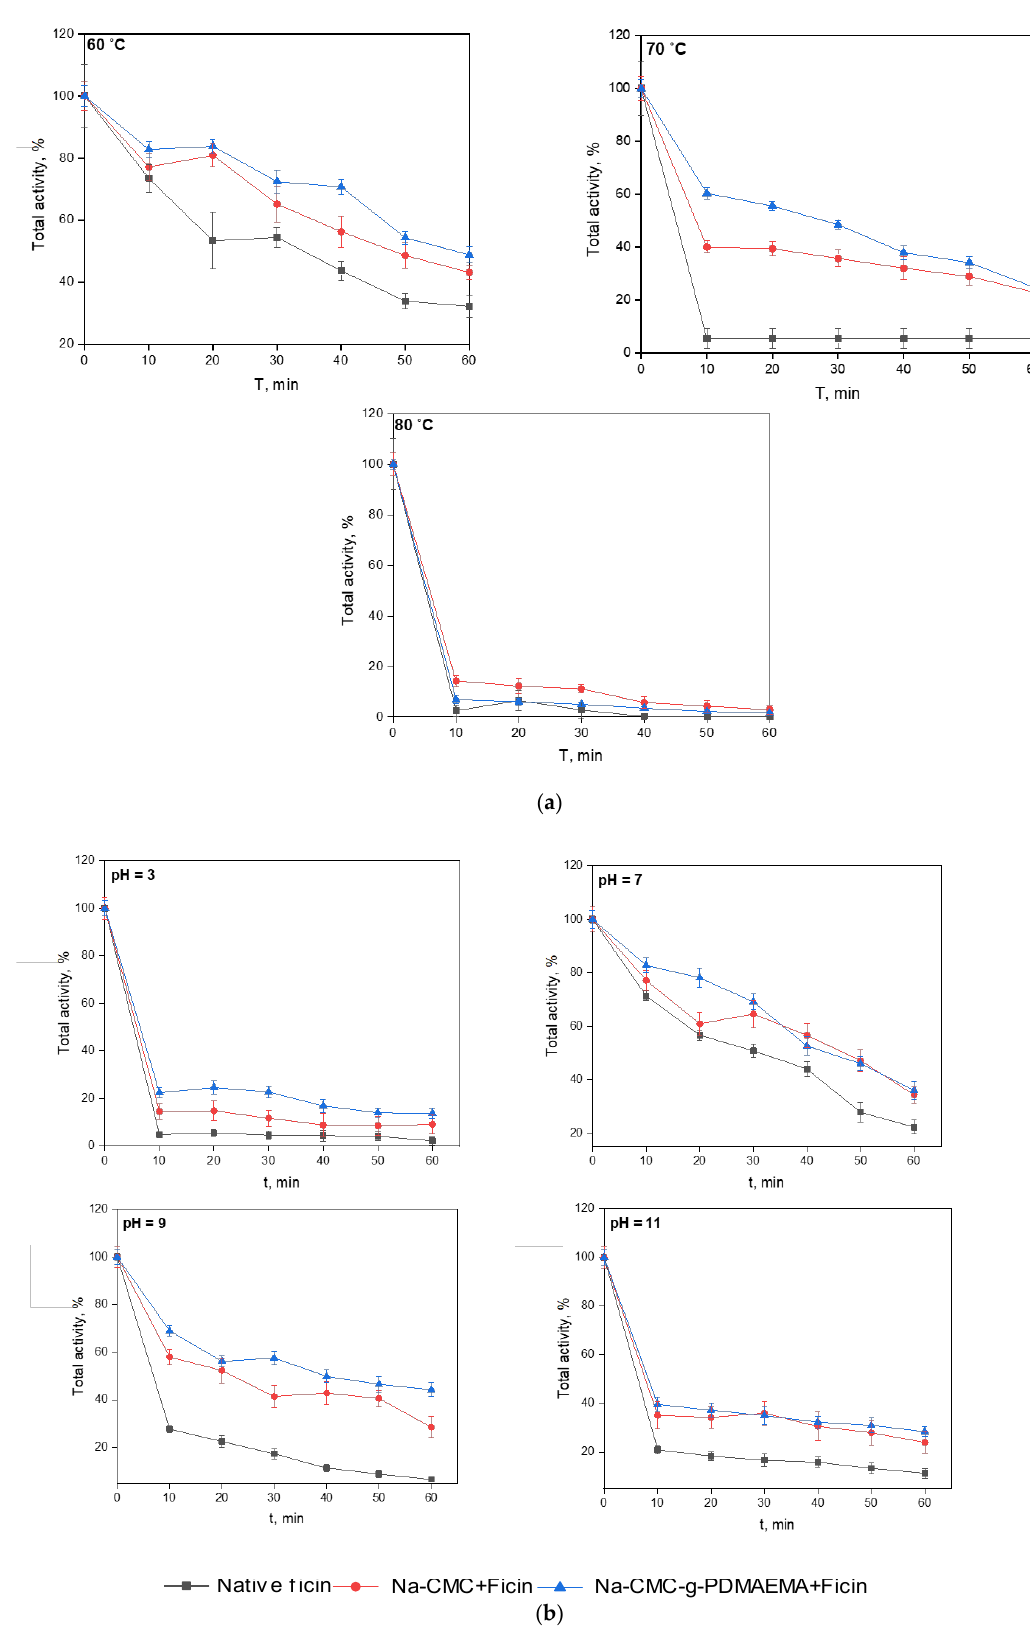
Figure 9. Thermostability ( a ) and pH-stability ( b ) of native and immobilized ficin. Experiments were performed at constant substrate concentration of 0.4 % w.